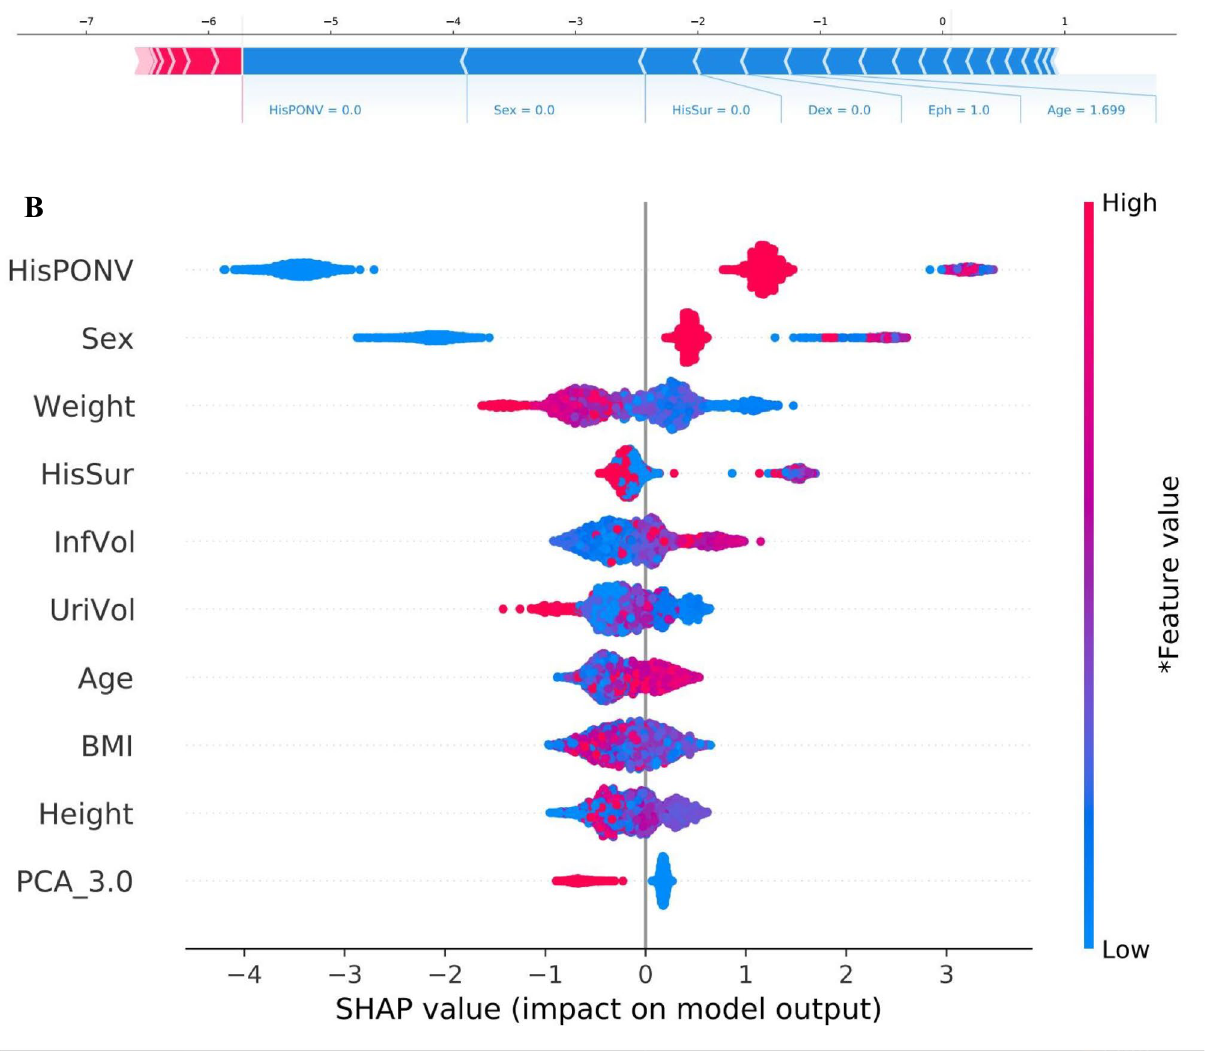
Figure 2. Variable contribution to models by SHAP Value. ( A ) Contribution of each feature value in one sample. ( B ) The SHAP value of the top 10 combination variables. The higher the SHAP value of a variable is, the more likely nausea and vomiting. The redder the color of the variable, the larger the value, and the bluer the color of the variable are, the smaller the value. SHAP SHapley Additive ExPlanation, History of motion sickness and/or PONV HisPONV, history of surgery HisSur, InfVol Infusion volume, UriVol Intraoperative urine volume, BMI Body Mass Index, PCA_3.0 PCA regimen 3 (sufentanil, nonsteroidal anti-inflammatory drugs in the analgesic